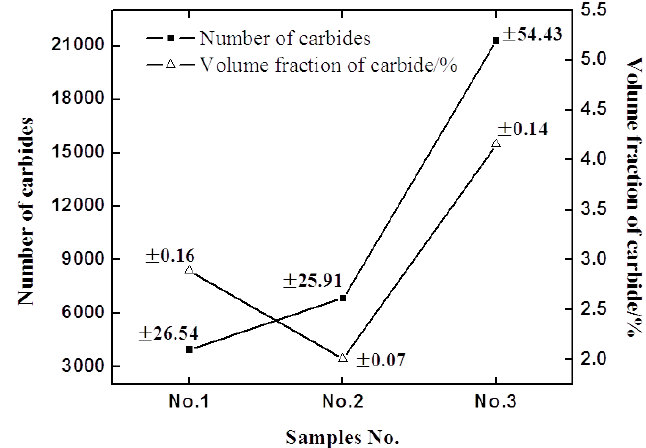
Figure 3. SEM images of specimens before and after spheroidizing annealing: ( a – c ) samples No. 1, No. 2, No. 3 before spheroidizing annealing; ( d – f ) samples No. 1, No. 2, No. 3 after spheroidizing